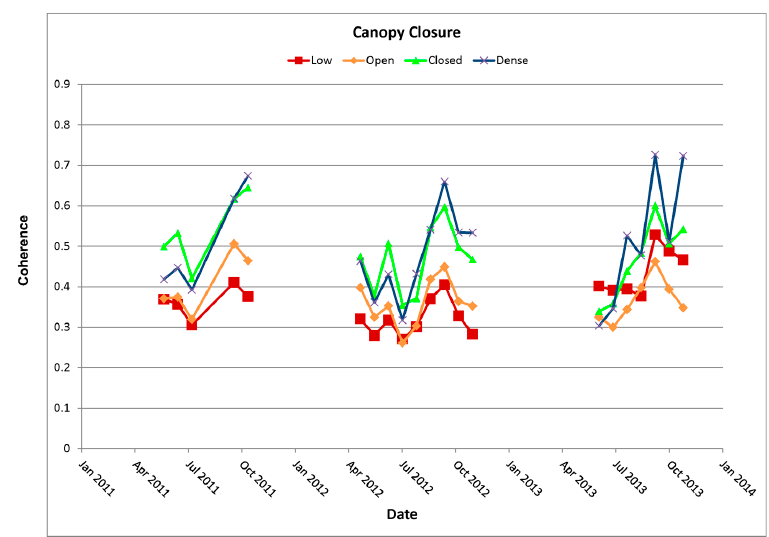
Figure 4. Coherence as a function of time for four canopy closure classes.